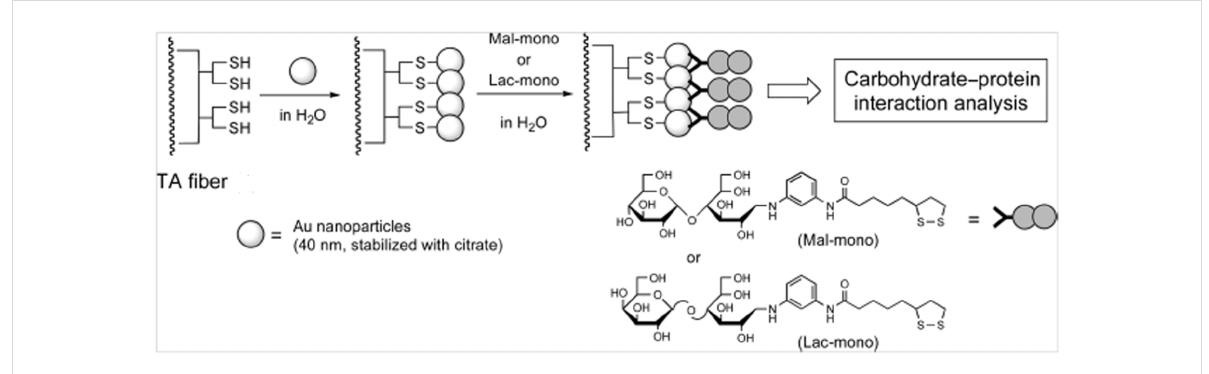
Figure 6: Design of the fiber-type “Sugar Chips”. AuNPs are firstly immobilized on an optical fiber functionalized with α -lipoic acid (TA fiber). Succes- sively, glycosil-thioctic residues were grafted on AuNPs, forming the “Sugar Chips”. Reprinted with permission from [82]. Copyright 2017 American Chemical